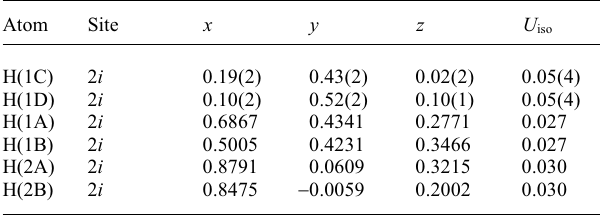
Table 2. Atomic coordinates and displacement parameters (in Å 2 ) .